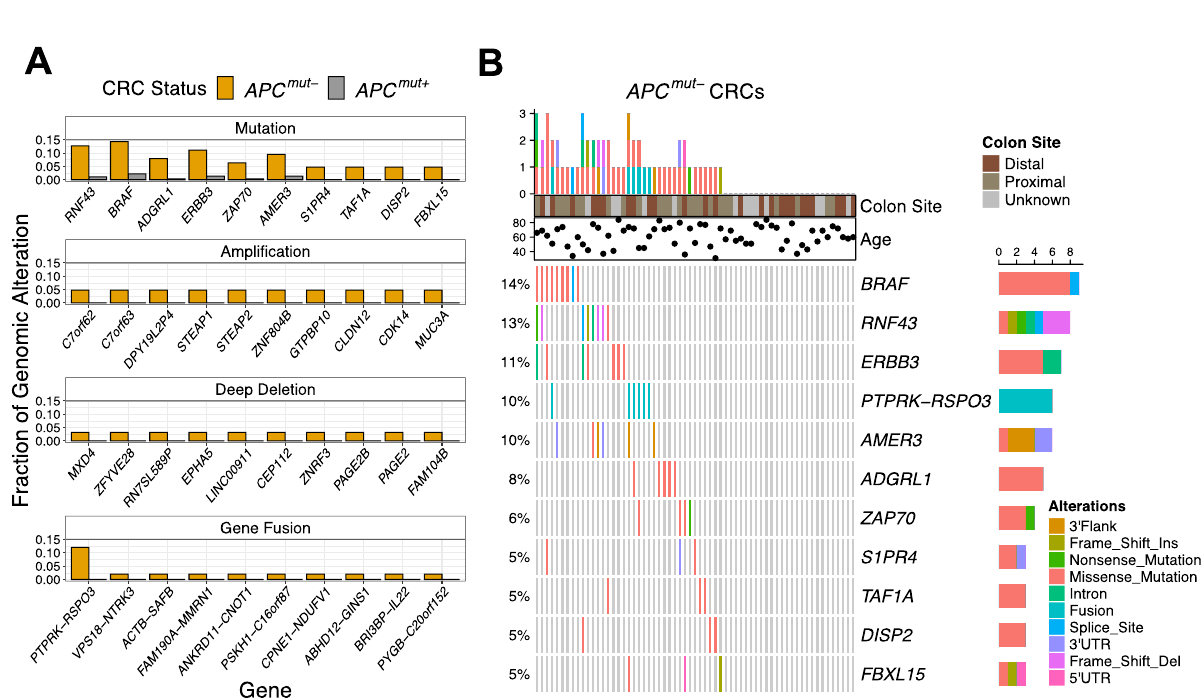
Figure 1. WNT signaling mutations in APC mut– CRCs. ( A ) Fraction of APC mut– CRCs from the TCGA dataset with gene mutations, amplifications, deep deletions, and fusions that were significantly more common in APC mut– in comparison to APC mut + CRCs. The top 10 are shown by p-value ranking, most significant (left) to least (right). ( B ) OncoPrint diagram showing the top 10 statistically significant mutations associated with APC mut– CRCs and the gene fusion PTPRK-RSPO3 for the 63 APC mut–